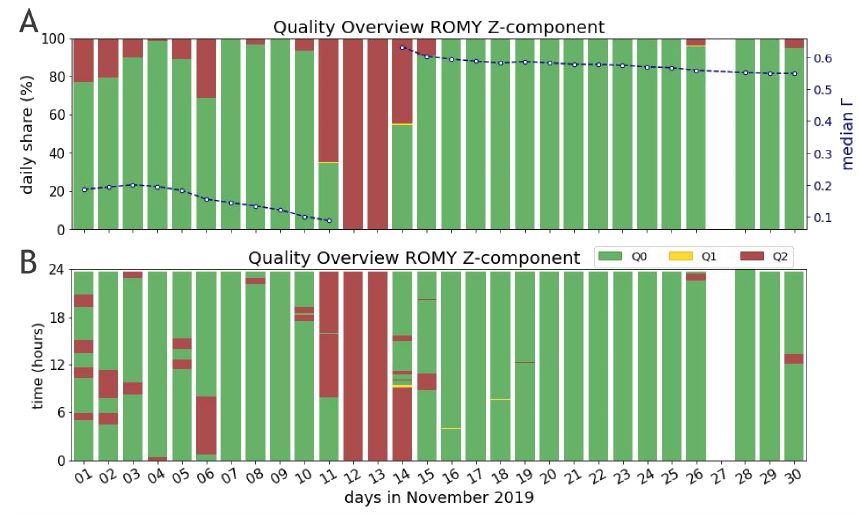
Figure 5. Data of ROMY’s z-component for November 2019 is shown in ( A ) as daily shares and in ( B ) across daily hours, in order to visualize the temporal quality distribution. No data is available for the z-component on 27 November 2019. The data is evaluated for 20s based on 2s windows and color code according to three quality levels Q0 (good), Q1 (medium) and Q2 (bad). ( A ) additionally shows the daily median of the contrast Γ computed by using Q0 and Q1 data only.